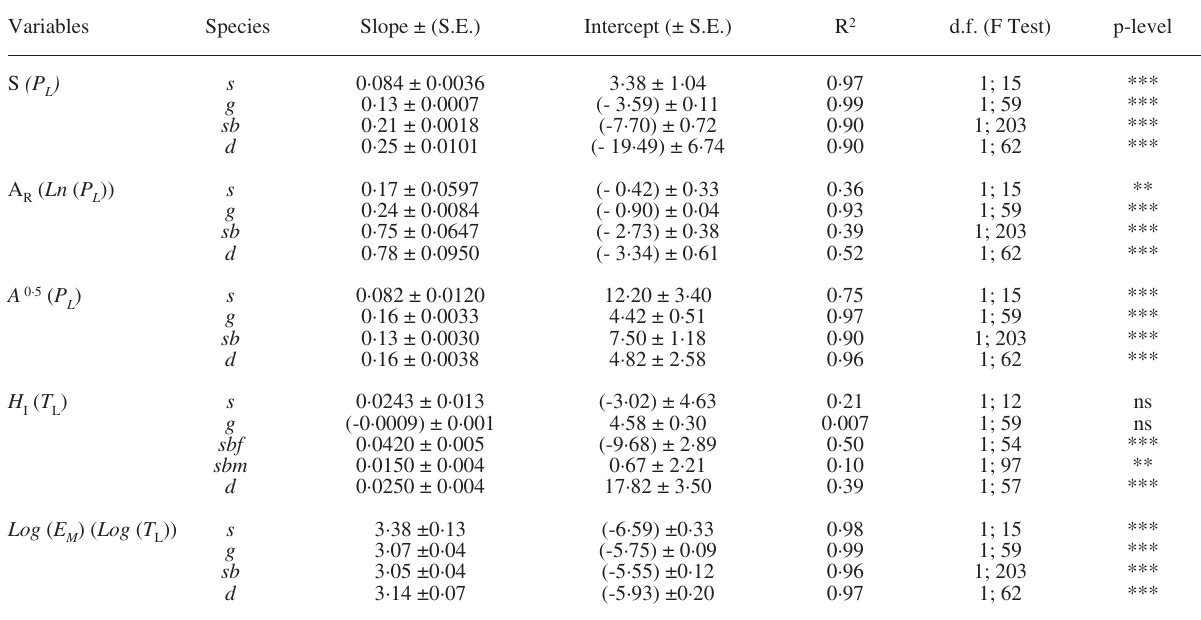
), hepatosomat- r : pre-caudal length; l